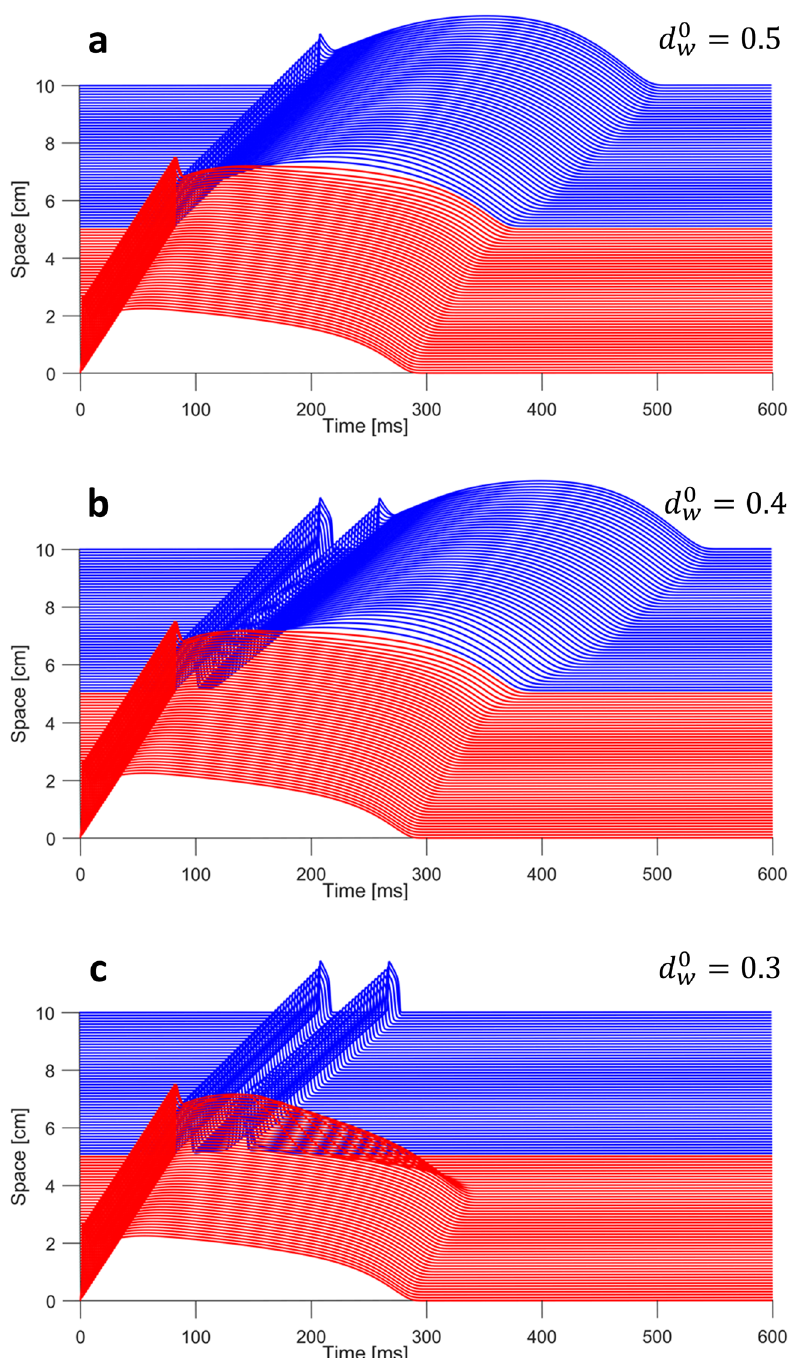
0 w . For each situation, a 0 = 0.5 ; a delayed dome action potential w 0 = 0.4 ; P2R generates a delayed dome AP w 0 = 0.3 ; P2R generates a new lost dome w